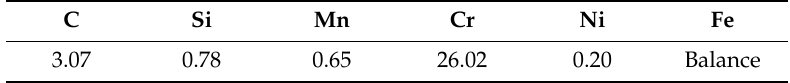
Table 1. Nominal chemical composition of the high-Cr white cast iron (WCI)